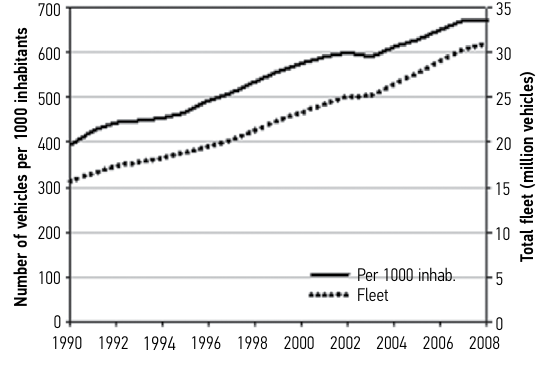
Fig. 1. Trends in vehicle fleet in